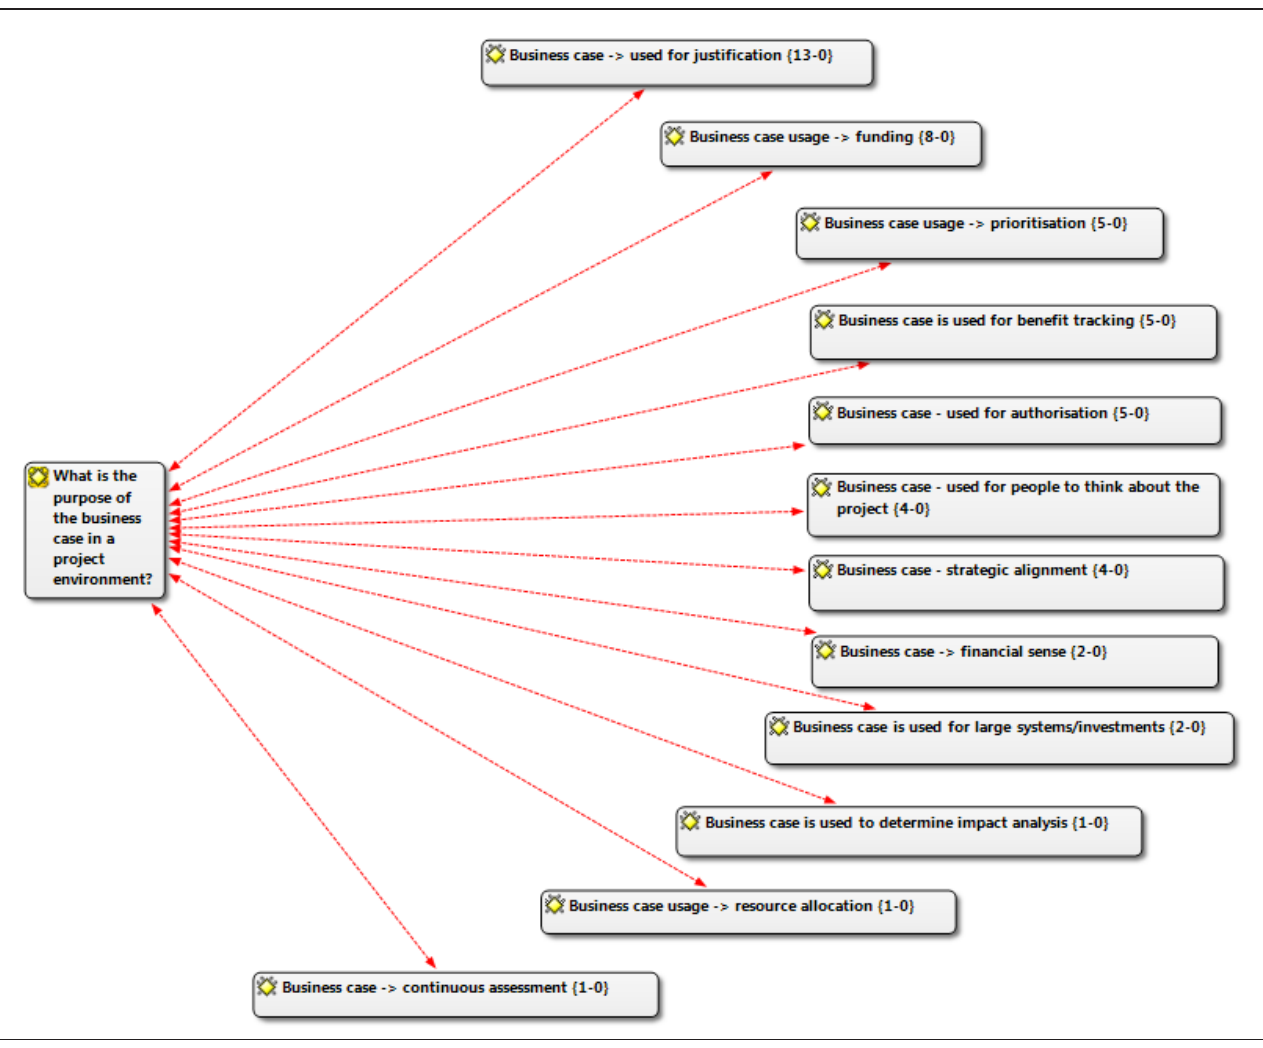
FIGURE 5: Network view: Inductive codes reflecting the purpose of the business